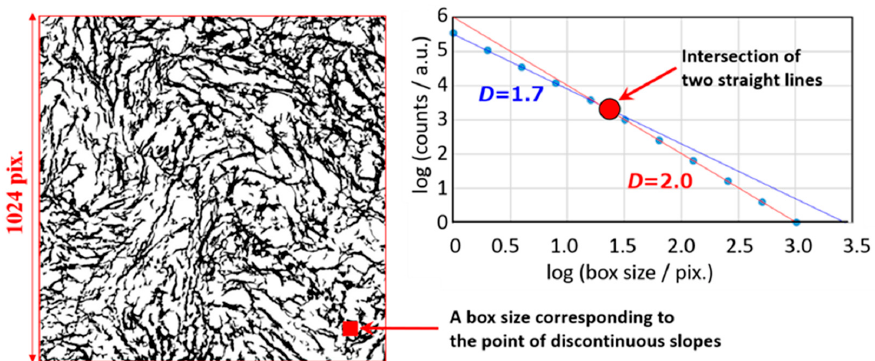
Figure14. Theboxcountinganalysisforimageanalysisofmicrographsforabnormalfibrousdistribution Figure 14. The box counting analysis for image analysis of micrographs for abnormal fibrous